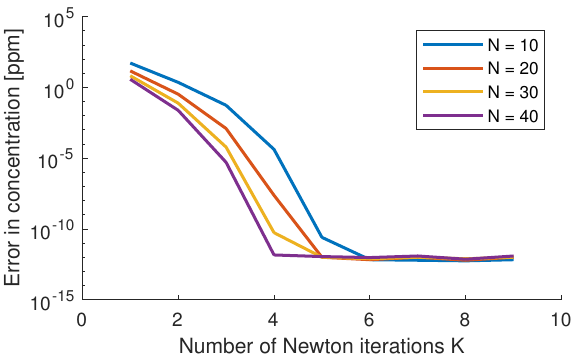
Figure 3. Maximal instantaneous error of any output concentration for different number of Newton iterations K and number of segments N . Simulation with K = 10 for respective N is used as